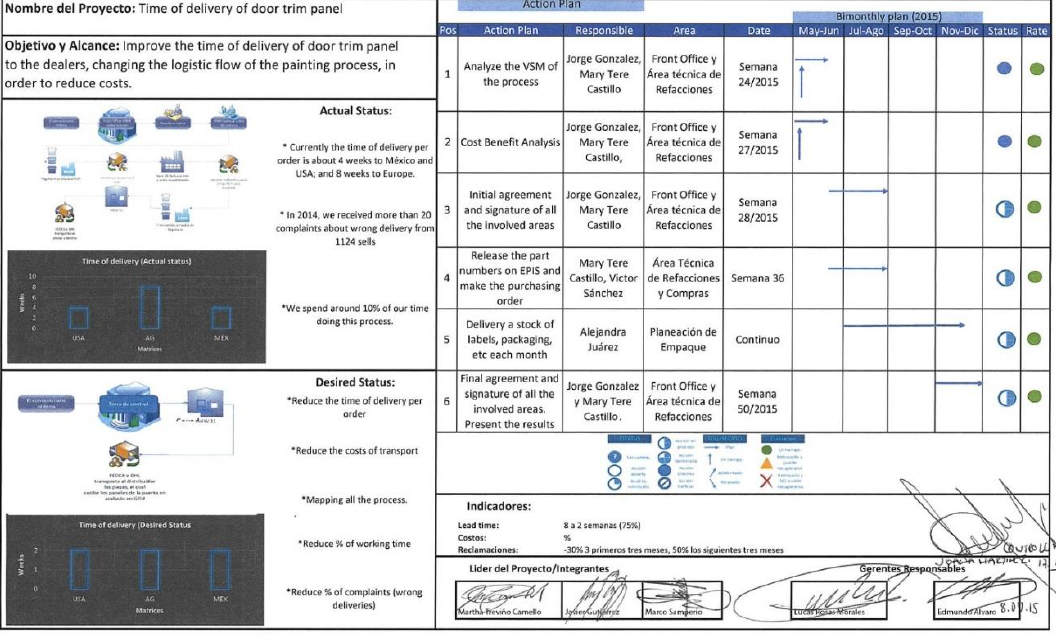
Figure 23. Proposal A3 Report.